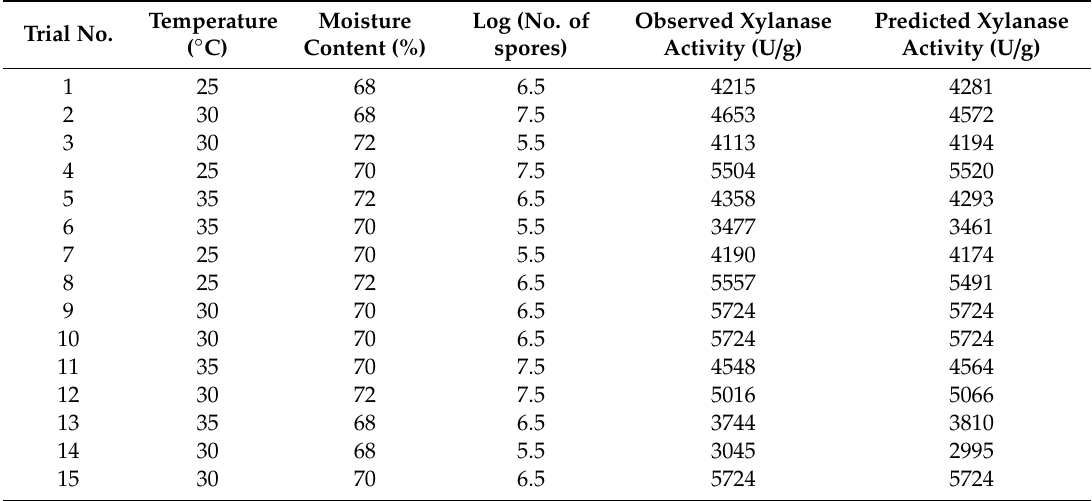
Table 4. Box–Behnken experimental design for SSF optimisation employing three independent variables, experimental, and predicted values for xylanase